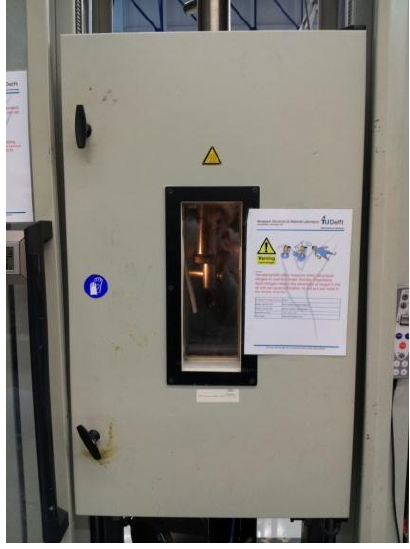
Figure 2. Climate chamber. Table 3. GFRP laminate specimens for flexural